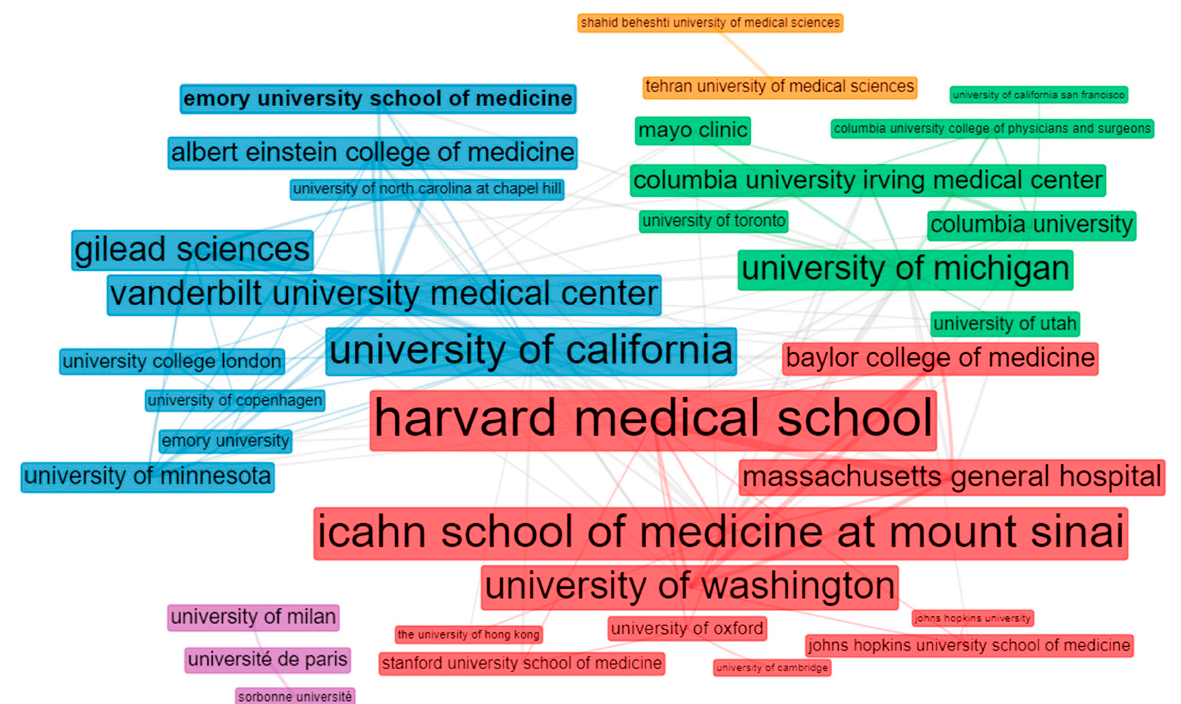
Figure 7. Visualization of institution collaborations.